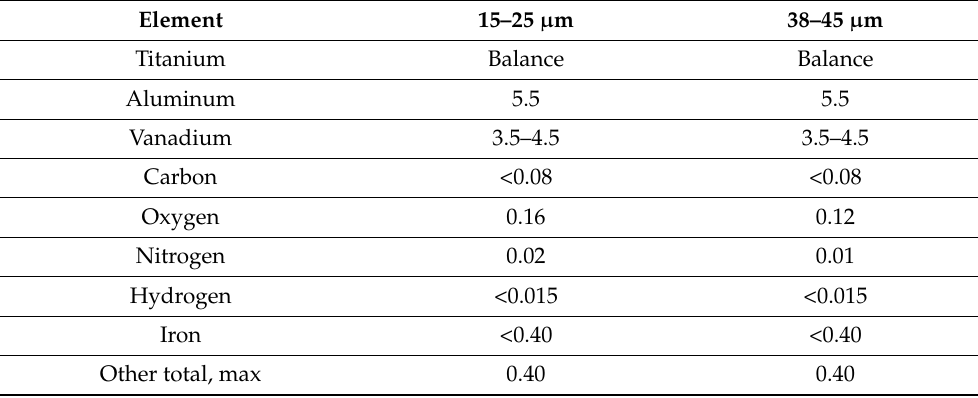
Table 1. Chemical composition of Ti6Al4V by wt.%.